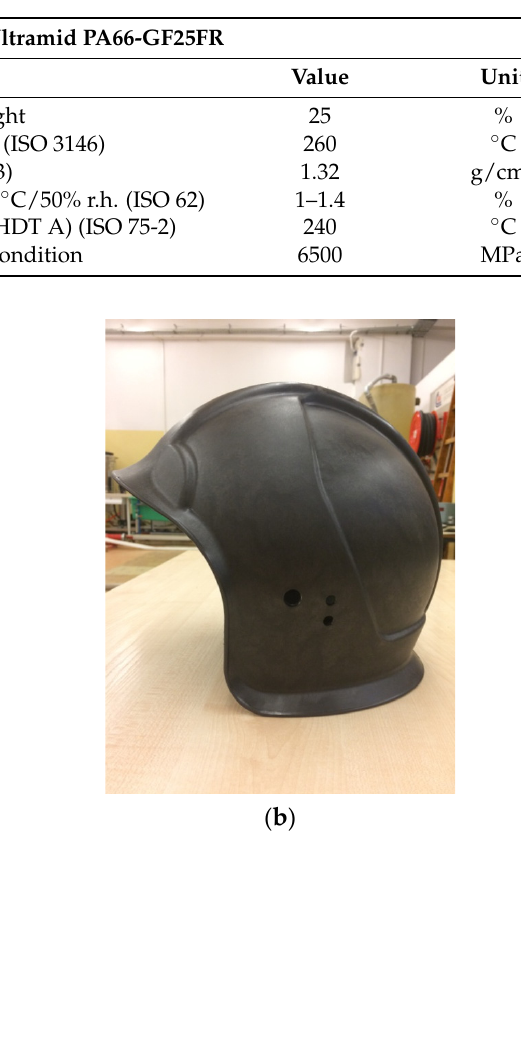
Table 1. Characteristic parameters of the Ultramid composite as given by the manufacturer (BASF) [16].